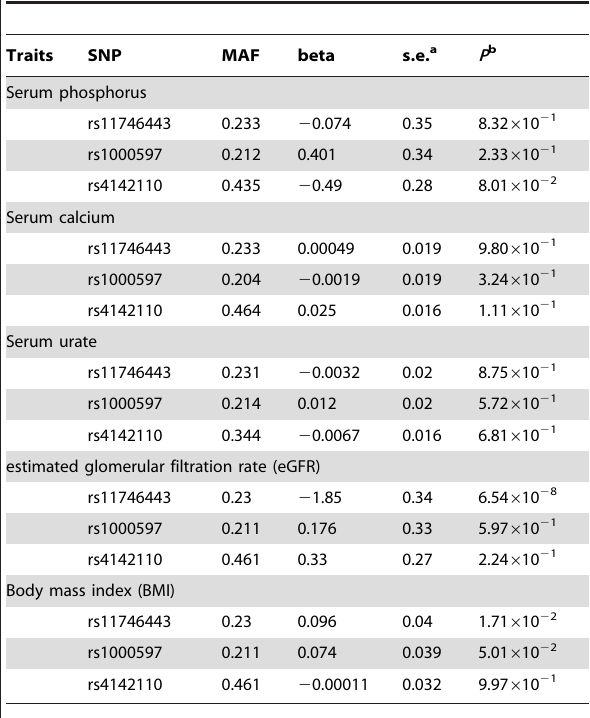
Table 2. QTL analysis for serum phosphorus, serum calcium, serum urate, eGFR, and